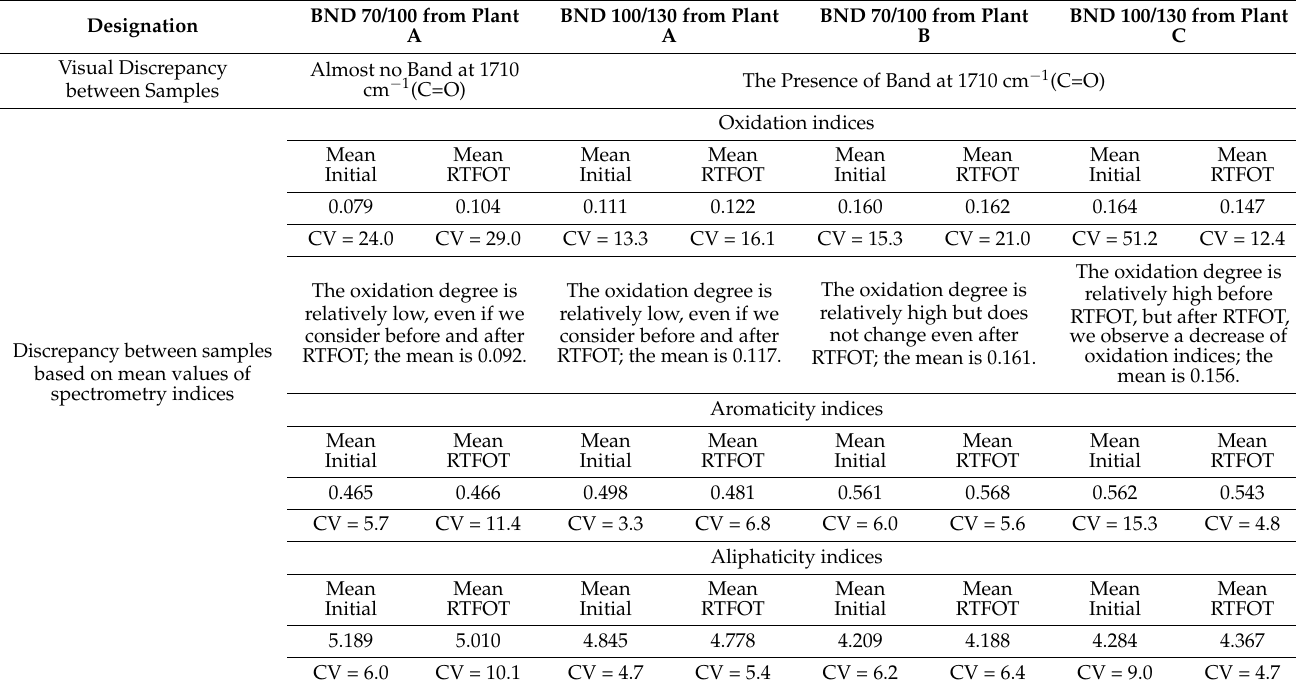
Table 14. Summary of Fourier-transform infrared spectroscopy